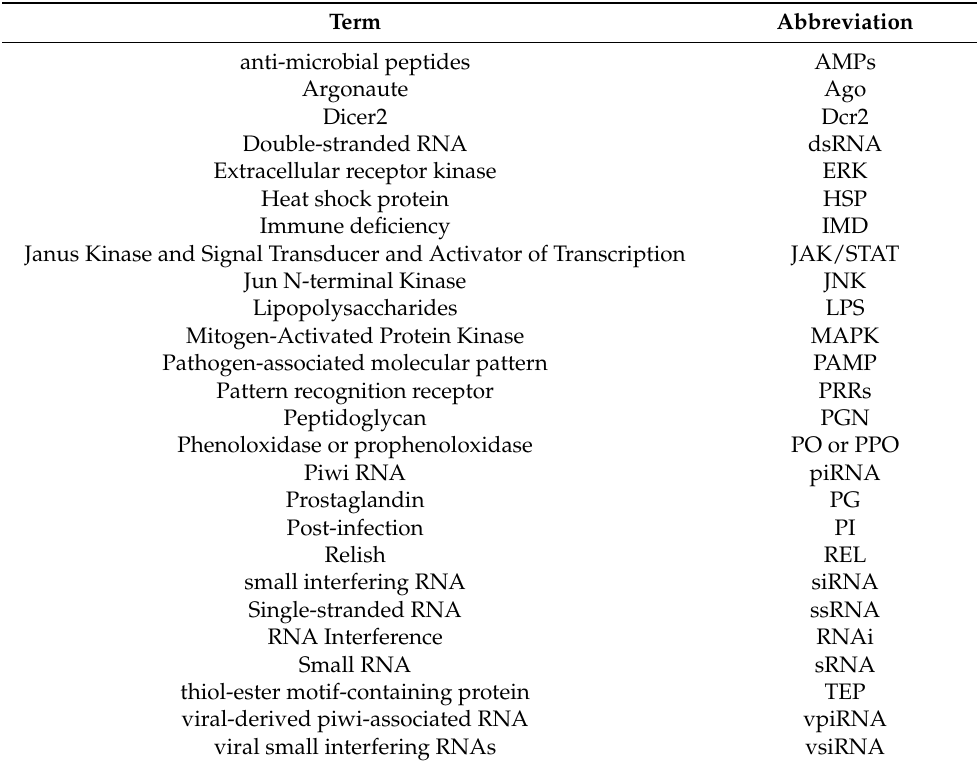
Table 1. Definitions of the reoccurring